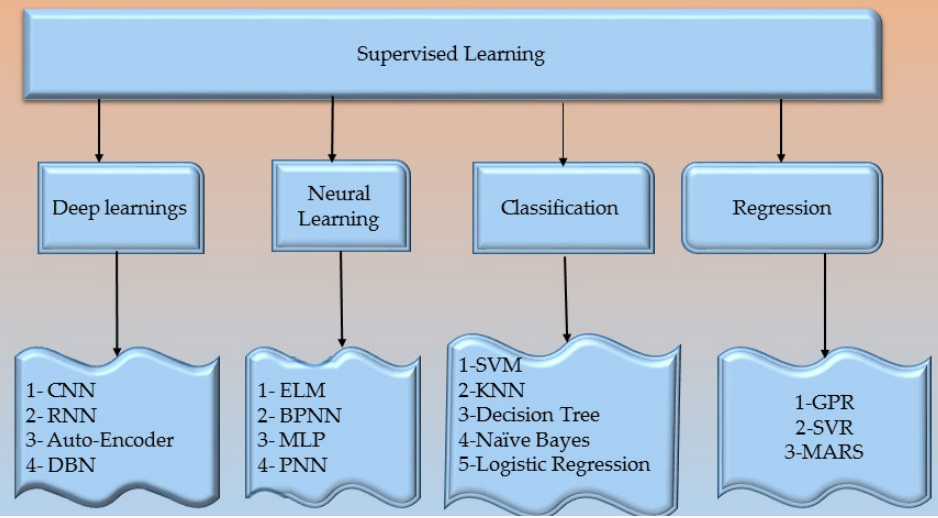
Figure 8. Supervised learning techniques in the smart grid.